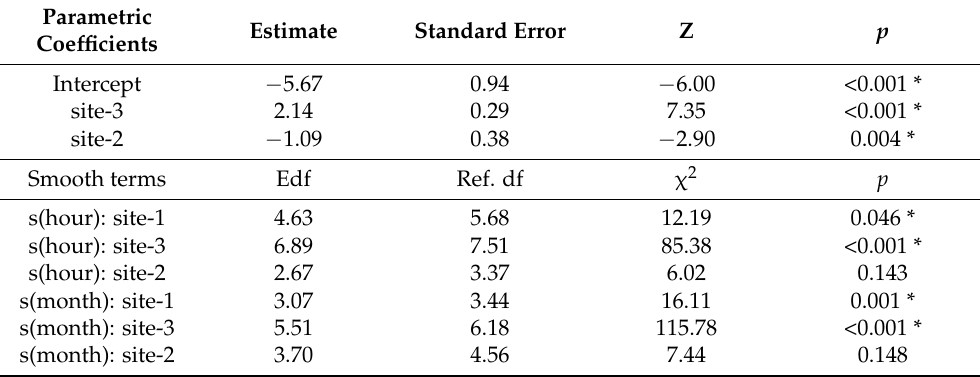
Table 6. The table below summarizes a negative binomial GAM model used to examine the effect of recording time and month on C. canorus ’s activity. The recording hour and month were modeled independently with smoothed function for each monitored site, while the cyclic predictor was modeled using a cyclic cubic regression spline. Reference degrees of freedom was used to calculate test statistics and p -values are represented by Ref. df, whereas Edf (Effective degrees of freedom) indicates the curviness of the relationship.